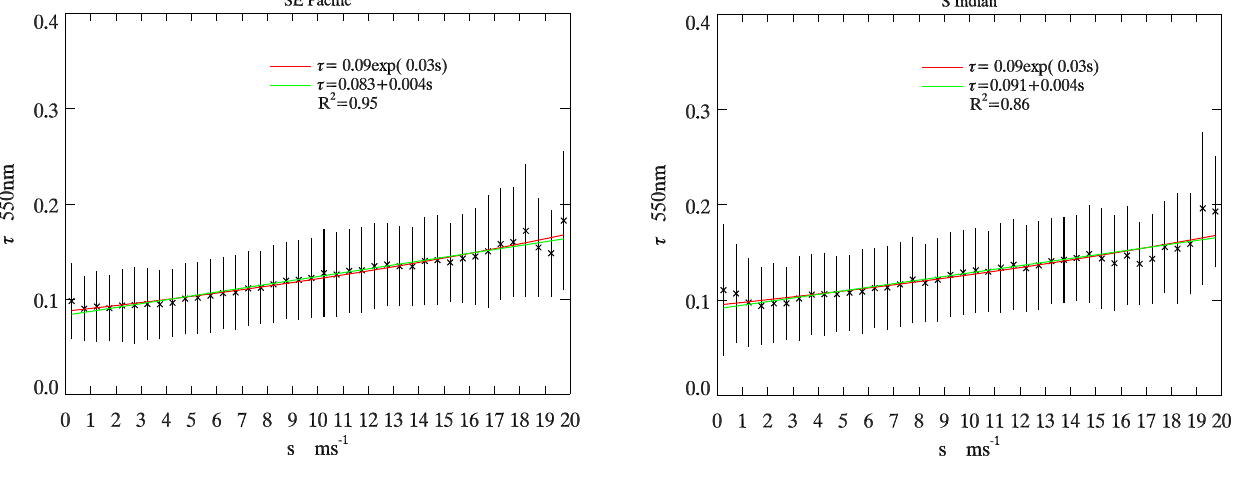
South East Pacific ocean region. R 2 in the plot is the linear correla- Fig. 6. Relationship between wind speed s and AOD τ over the tion coefficient between wind and τ South East Pacific. R 2 in the plot is the linear correlation coefficient